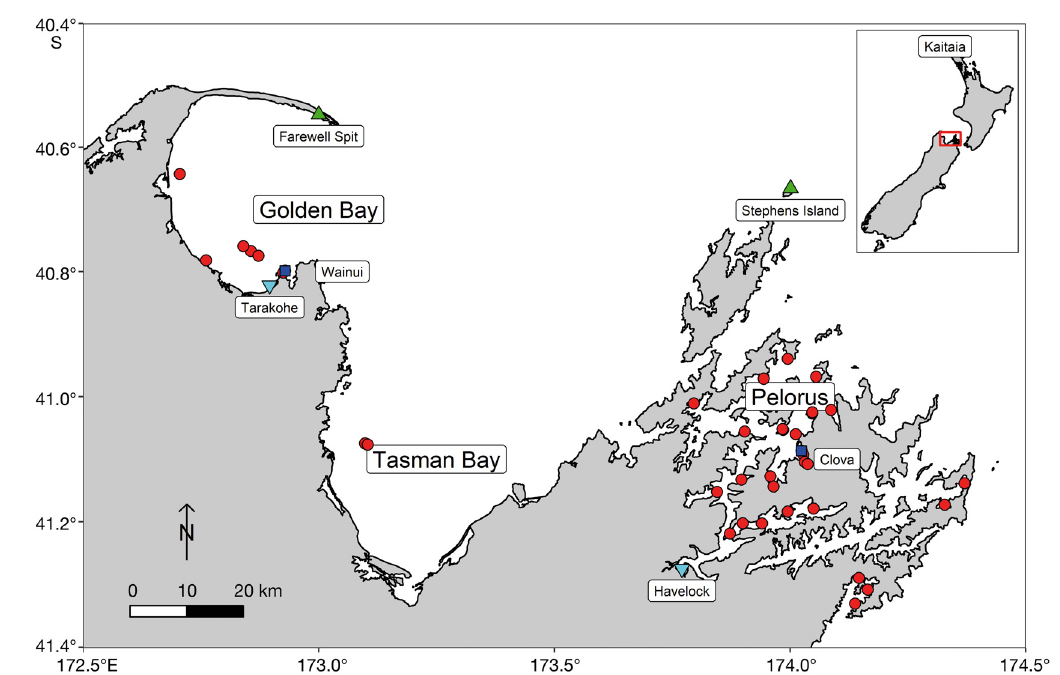
Fig. 1. The study area, in relation to New Zealand (inset), showing the main sub-regions relevant to this study: sampling sta- tions ( d ), climate stations (i.e. Farewell Spit and Stephens Island, m ), tidal range stations (Tarakohe and Havelock, z ) and sites used for the predictive models (i.e. Wainui and Clova, j ). The inset also shows the location of Kaitaia, the area where the largest proportion of green-lipped mussel Perna canaliculus spat is obtained